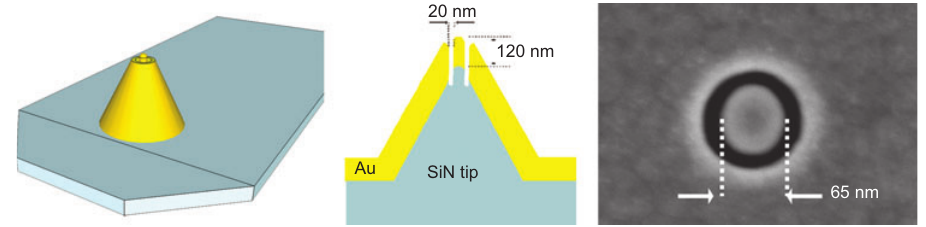
Figure 5 Schematics and SEM image of coaxial probe tip with ring-shaped aperture. Reprinted with permission from [76] . Copyright 2011, American Chemical Society; left image courtesy of A. Weber-Bargioni, The Molecular Foundry, Berkeley,